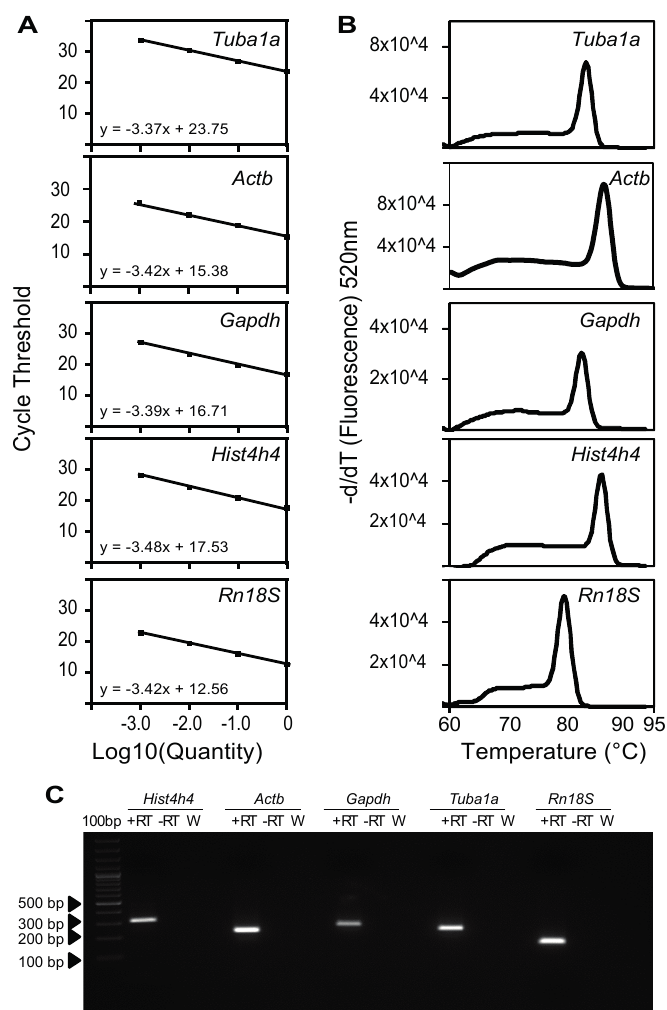
Figure 2. Characterization of primer pairs designed for expression analysis of the internal control during mouse lung development. ( A ) Amplification efficiency for each primer pair was calculated using 10-fold serial dilutions of a cDNA template. Primer amplification efficiency was assessed by plotting the cycle threshold ( C T ) value for each concentration against the logarithm (base 10) of the fold dilution (log 10 (Quantity)). Efficiency was calculated using the slope of the linear function; ( B ) Dissociation curve analysis of primer specific products was performed by constantly monitoring the fluorescence with increasing temperatures from 60 to 95 °C. Melt curves were generated by plotting the negative first derivative of the fluorescence ( − d/d T (Fluorescence) 520 nm) versus temperature (degree Celsius, °C); ( C ) Agarose gel electrophoresis after qRT-PCR indicates a specific product for each of the primer pairs. +RT, template is cDNA; − RT, template is RNA without reverse transcriptase, W, water